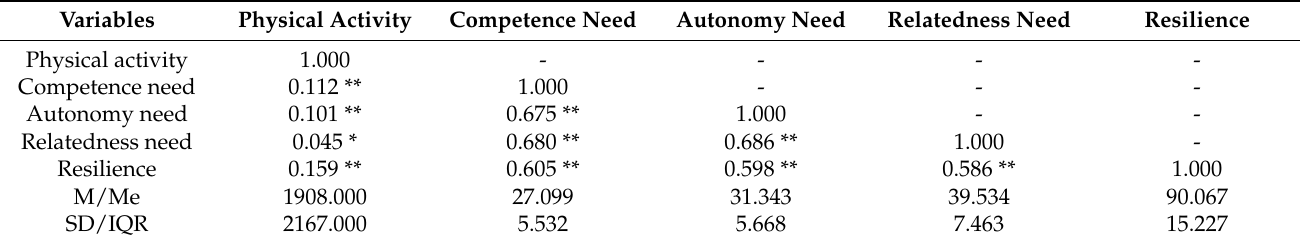
Table 1. Descriptive statistics and correlation matrix for physical activity, basic psychological needs satisfaction, and